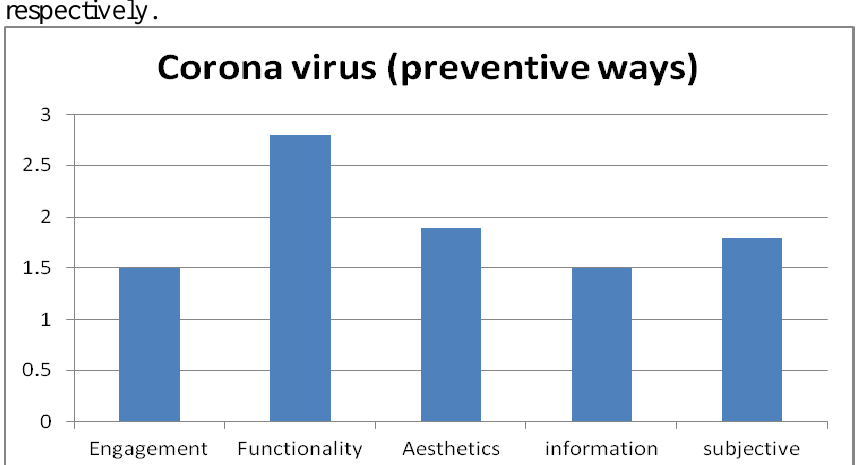
Fig13. The evaluation of indicators in Corona virus (preventive ways) according to MARS